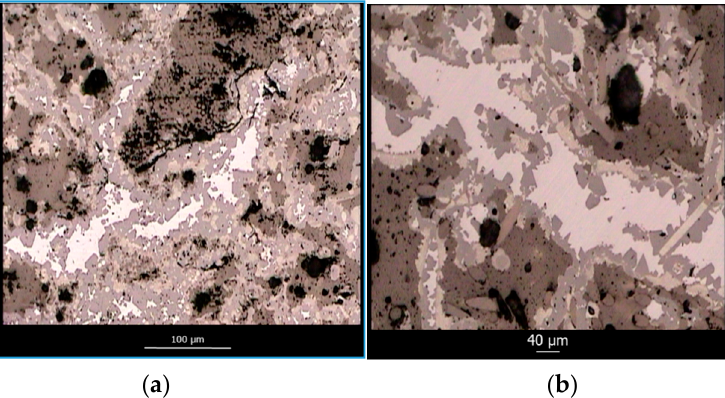
Figure 11. Representative micrographs of polished cross-sectioned C f /SiC specimens with a low ( a ) and a high ( b ) magnification.